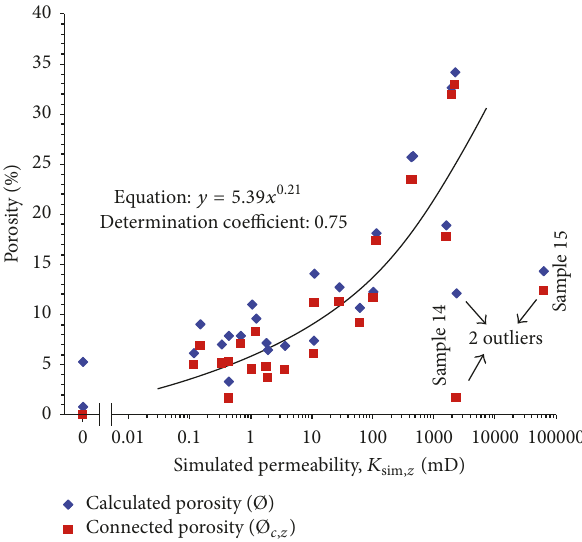
Figure 12: Cross-plot of the calculated total and connected 𝜇 CT porosity (resp., blue and red symbols) versus the permeability.